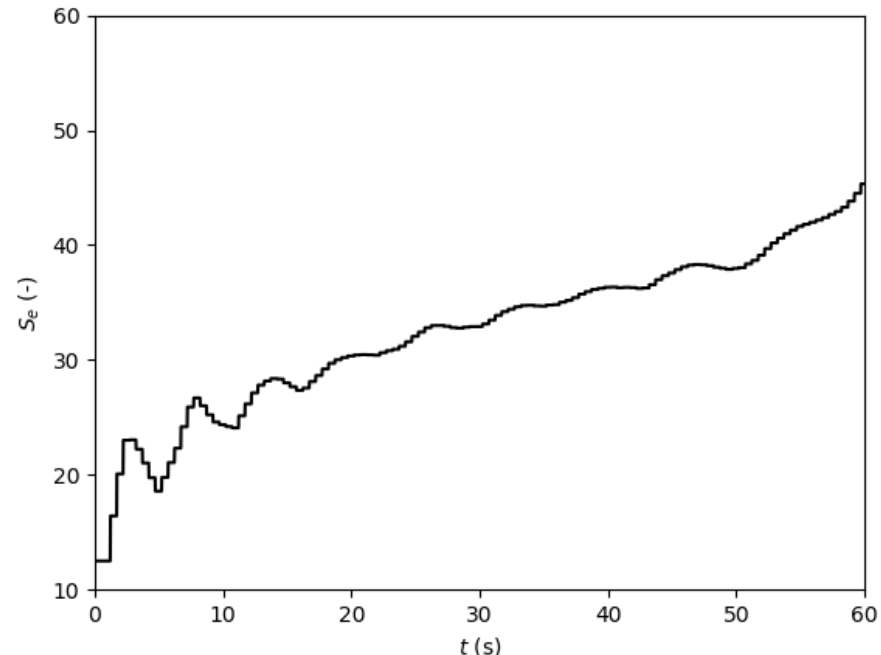
Figure A11. Effective swirl number profile, feedback with downgraded regulation law, case 3.